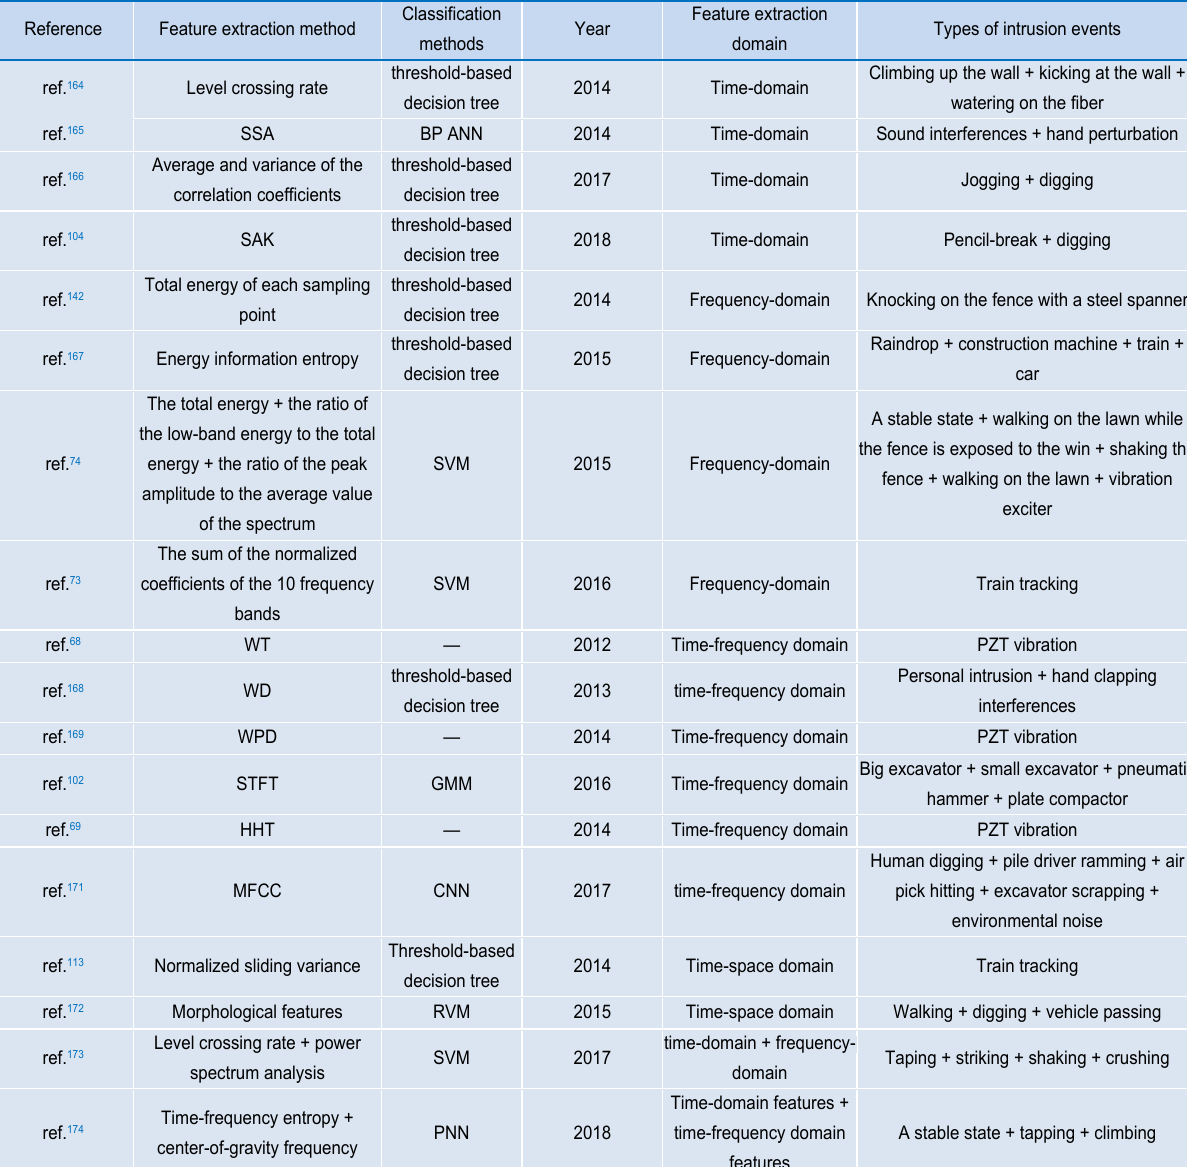
Table 5 | Research progress on event discrimination in Ф-OTDR